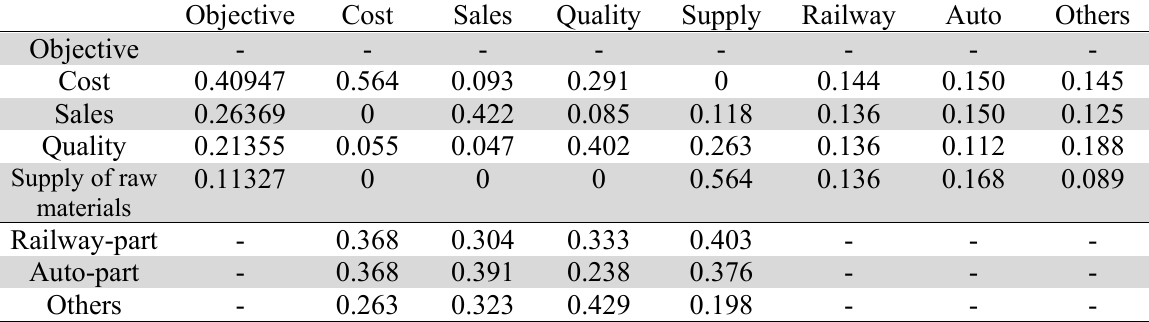
The summary of the results of super matrix